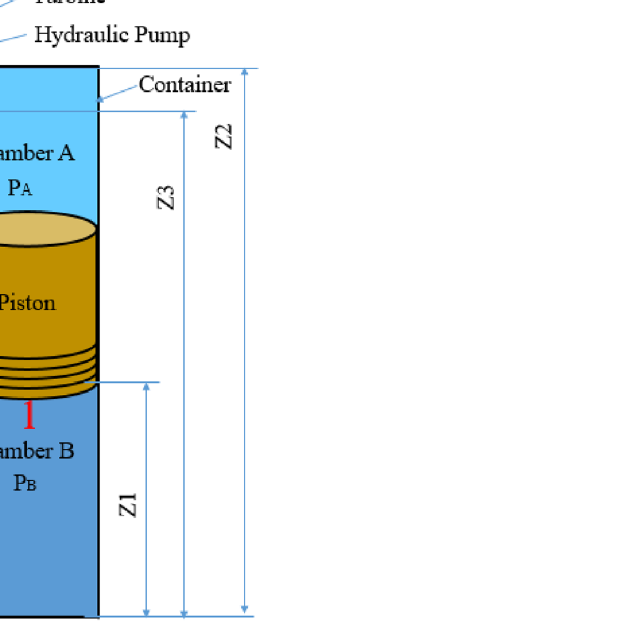
Figure 1. Schematic illustration of gravity energy